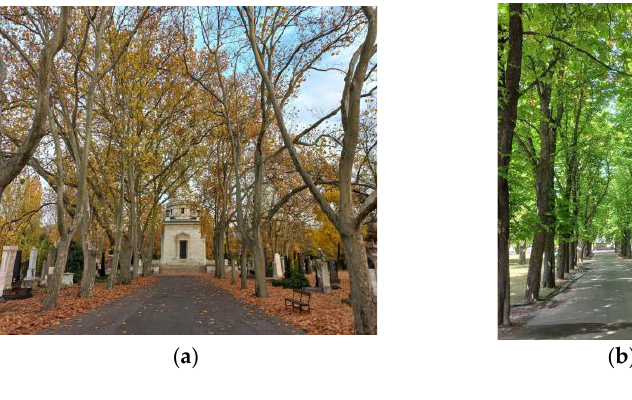
Figure 3. Nemzeti Sírkert, Budapest: ( a ) the sycamore alley leading to the Deák Mausoleum, ( b ) Figure 3. Nemzeti S í rkert, Budapest: ( a ) the sycamore alley leading to the De á k Mausoleum, chestnut alley, ( c ) landscaped plot (authors ’ photos, 2022). ( b ) chestnut alley, ( c ) landscaped plot (authors’ photos,